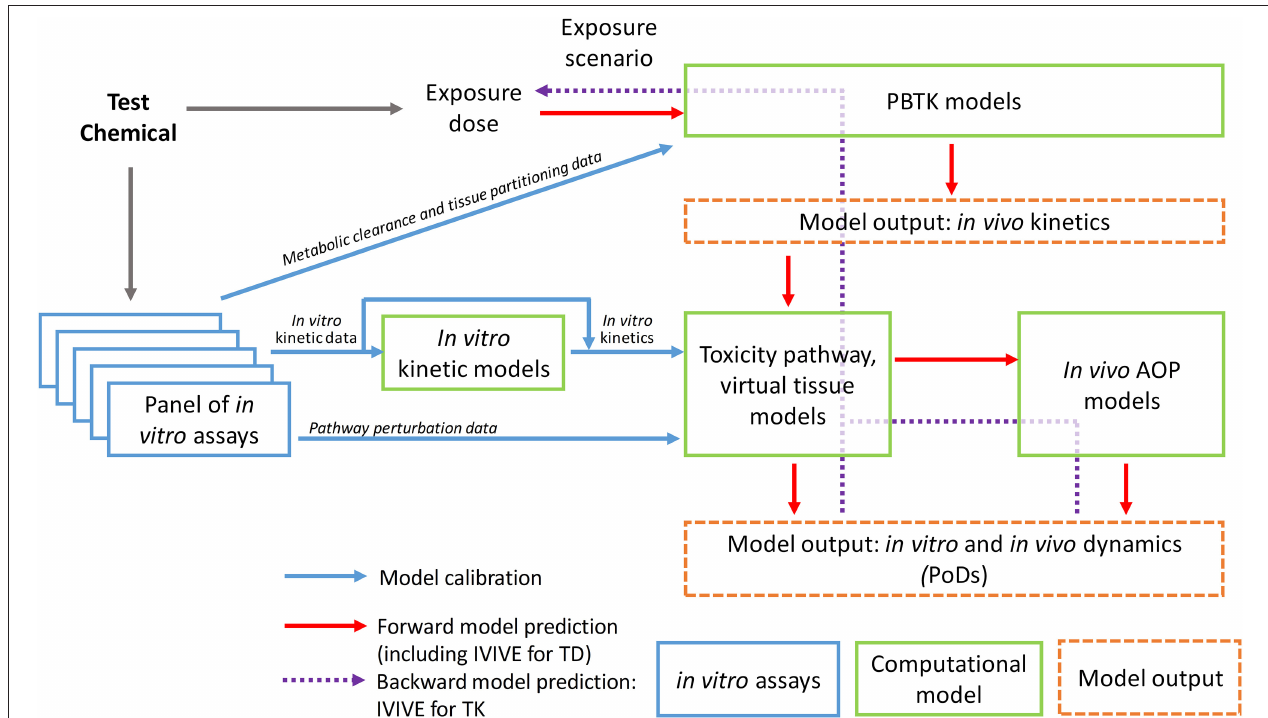
FIGURE 1 | Schematic illustration of the workflow of computational approaches supporting dose-response modeling and in vivo extrapolation based on in vitro testing data.